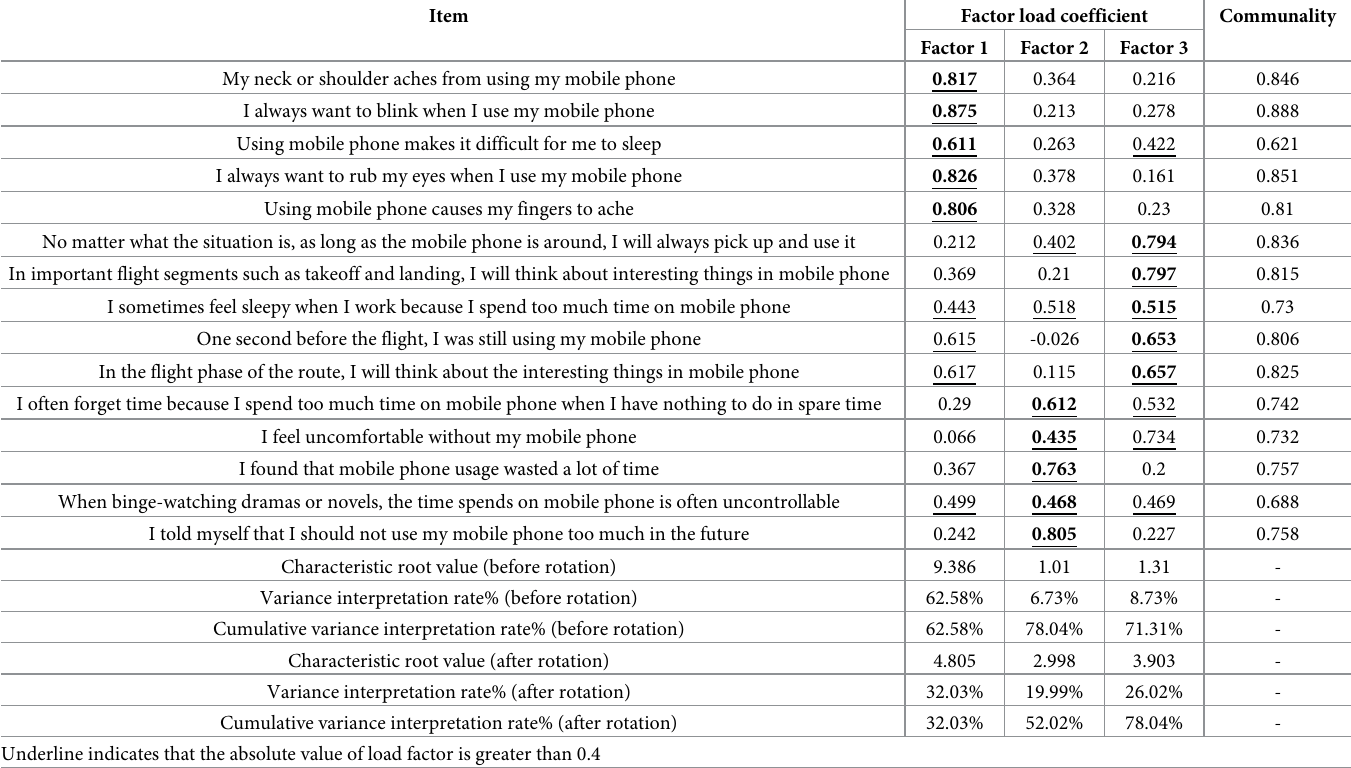
Table 4. Results of structure validity